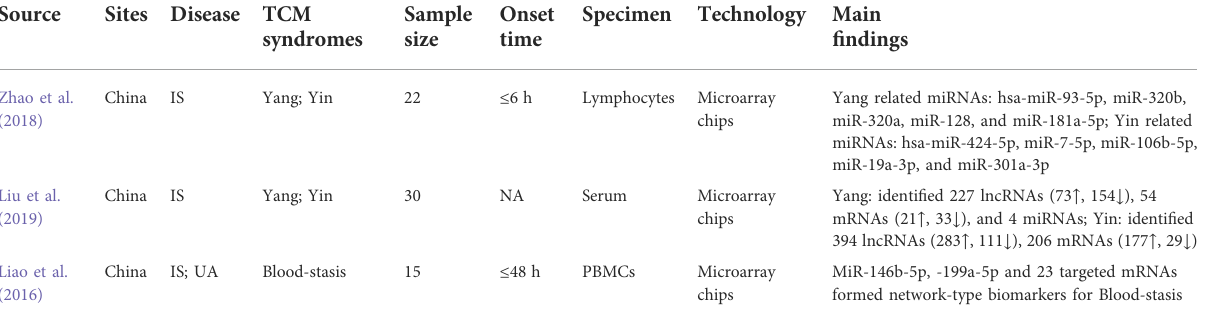
TABLE 2 Summary of the main fi ndings of the included transcriptomics